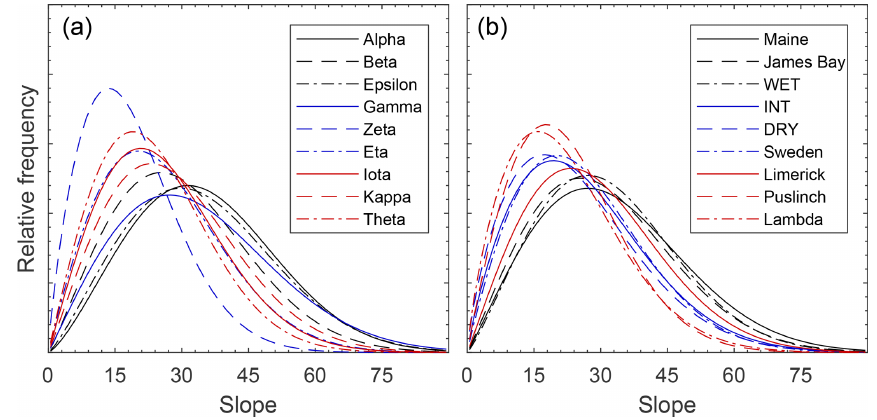
Figure 6. Plot-level Weibull probability density function of slope derived from the surface normal of a planar fit to elevation in a moving 0.03m × 0.03m window for all DEMs. Panels (a) and (b) separate the randomly and qualitatively chosen plots, respectively.